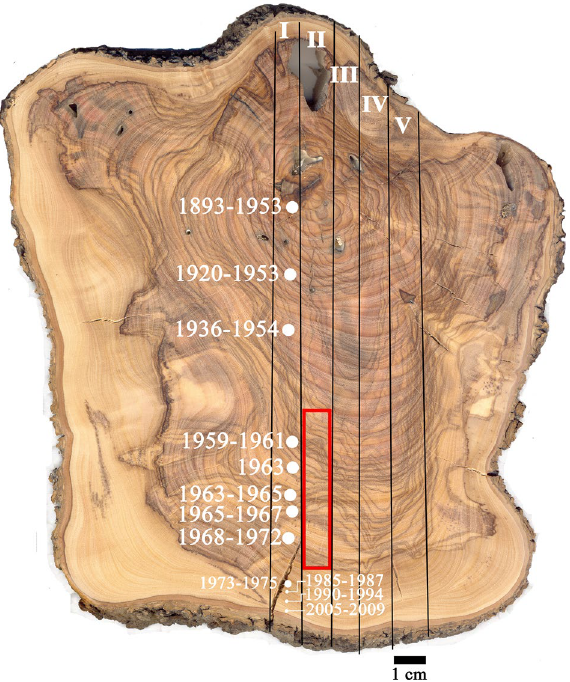
Figure 1. Olive branch cross-section. Five segments were cut along the section (I-V). Segment I was sampled at numerous points to obtain chronological data by radiocarbon dating. From segment II, 5 mm into the surface shown in the image, a 6 × 1x0.5 cm section (in red frame) was cut between the points dated 1959–1961 and 1968–1972, in order to contain the maximum point of the “bomb peak” period of increased atmospheric radiocarbon. This section from segment II was cut into a series of 96 independent samples that underwent radiocarbon dating and δ 13 C measurement. The tangentially parallel section was cut from above this segment, at the surface level shown in the image, for CT scanning following charring. The parallel section in segment III was CT scanned as fresh material. Segment IV was sampled for SEM–EDS analysis. A higher-quality image of the section is available in the supplementary